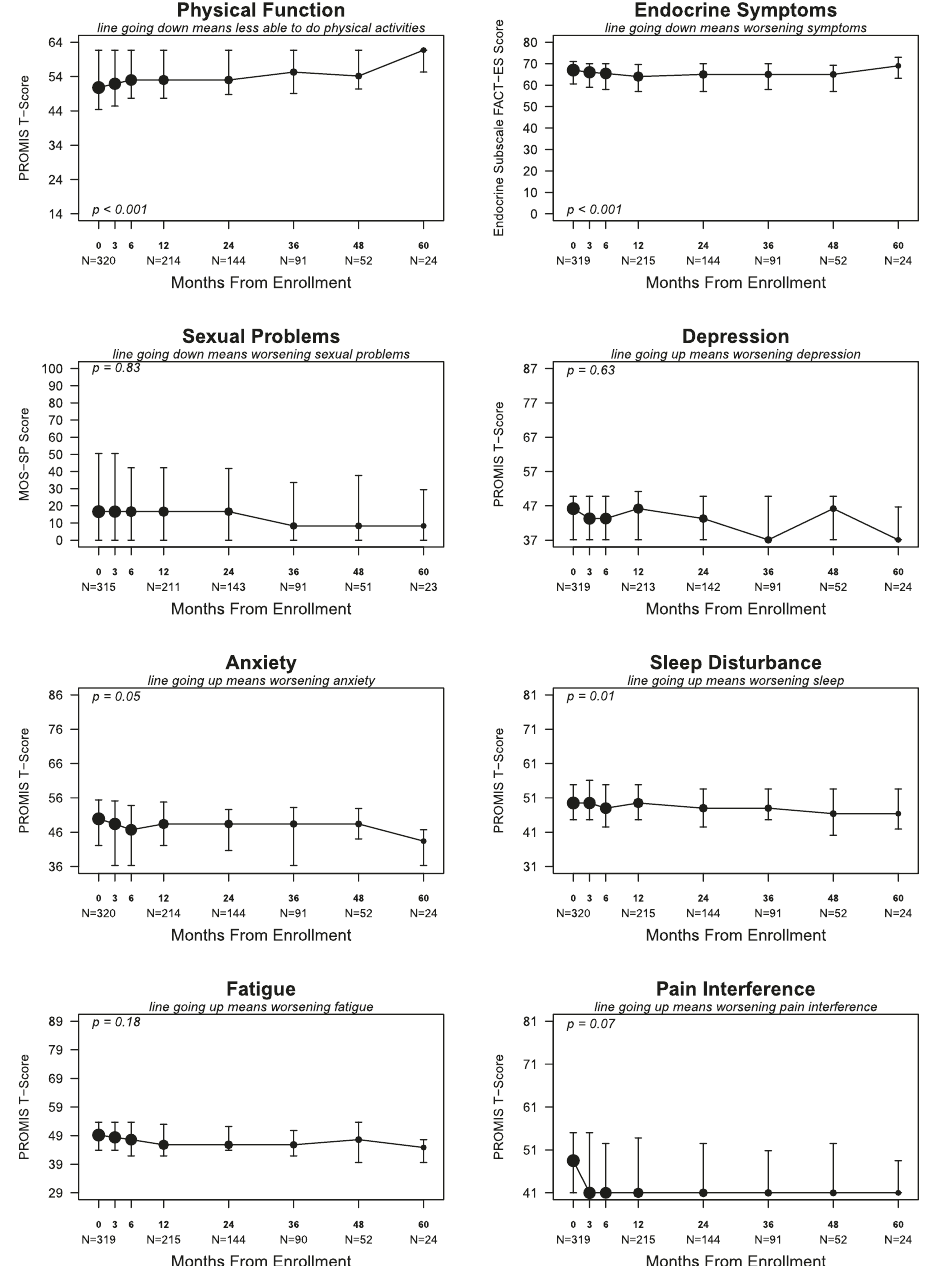
Fig. 1 Change in patient-reported outcome scores over time. Line graphs display median PRO scores at each time point. The size of each dot is proportional to the number of participants who completed the PRO measure at that time point. The numbers of participants who completed the PRO measure at baseline and at 12, 24, 36, 48, and 60 months point are noted under the X-axis at the corresponding time points. The Y-axis denotes the score range for each PRO measure. Bars represent interquartile ranges. P -values summarize overall mean change in PRO scores during the fi rst 24 months compared to baseline with a four-degree-of-freedom test. PRO patient-reported